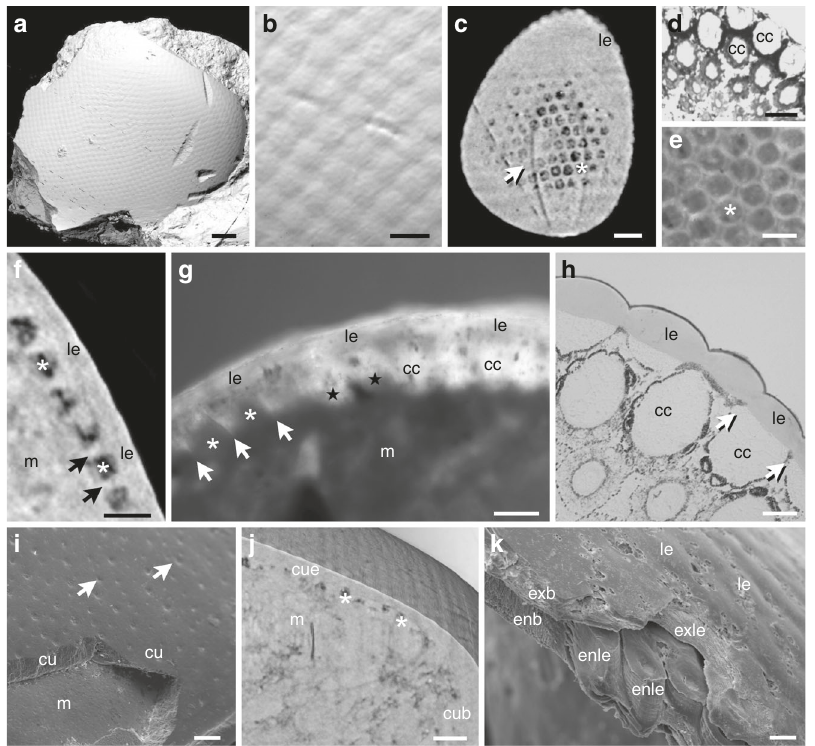
Fig. 2 The compound eye of Asaphus sp. compared with those of a Recent centipede and xiphosuran. Trilobite images show specimens of the Lindström collection (see Pl. 1, Figs. 28, 30 of Lindström 21 ). a , b , c , f, i Synchroton scans of Ar0019635. e , g Semi-thin sections of Ar0059402, j SEM of Ar0019635. a Surface rendering of the Asaphus eye. b Close up of a showing the convex hexagonal facets. c Tangential section of a underneath lenses with putative crystalline cones, indicated by dense fi lling (arrow), missing cones indicated by dark areas (asterisk). d Cross-section through round crystalline cones surrounded by dark pigment cells of the centipede Scutigera coleoptrata . As in Asaphus these lie underneath hexagonal lenses. e Asaphus tangential section. The white rings correspond to the pointed projections in g . f Transverse section of a . Asterisks mark absent cones, arrows mark ring-like processes. g Cross-section through the eye of Asaphus showing lenses, crystalline cones, displaced crystalline cones (stars), and missing crystalline cones (asterisks). Pointed projections (arrows) form rings surrounding the empty spaces (see e , f ). h Transverse section of a S. coleoptrata eye with cuticular lenses and cellular crystalline cones. Arrows point to areas that correspond to the ring-like projections shown in d – g . i The fossilized cuticle of Asaphus with pores (arrows). j Section mode (cross-section) of a showing the transition between the thin cuticle of the eye and the thick cuticle of the body. Asterisks mark absent crystalline cones. k Fracture of the exuvia of the xiphosuran Limulus polyphemus . The cone-like projections of the round to hexagonal eye-lenses are part of the endocuticle. The endocuticle of the body is smooth. The exocuticle of the lenses and the body region lie on top. Scale bars 200 μ m ( a , i ), 50 μ